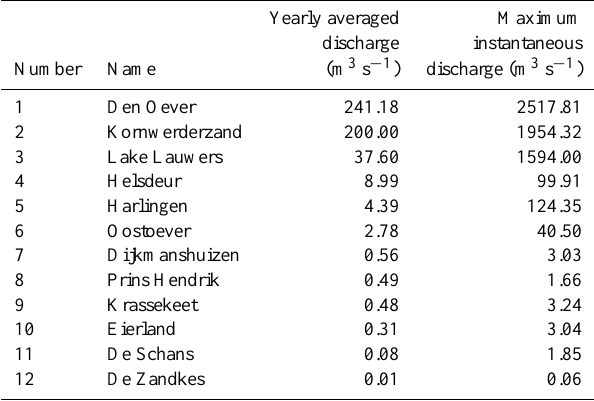
Table 1. Average and maximum freshwater discharge in m 3 s − 1 at the different sluices for the years 2009–2010. The sluice numbers correspond to those in Fig.